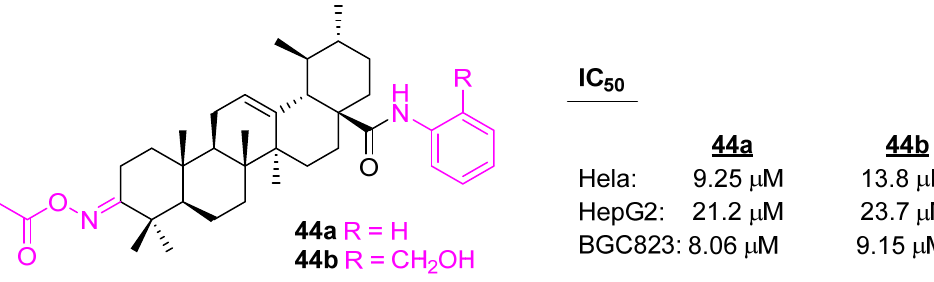
Figure 29. Structure of 44a , 44b .